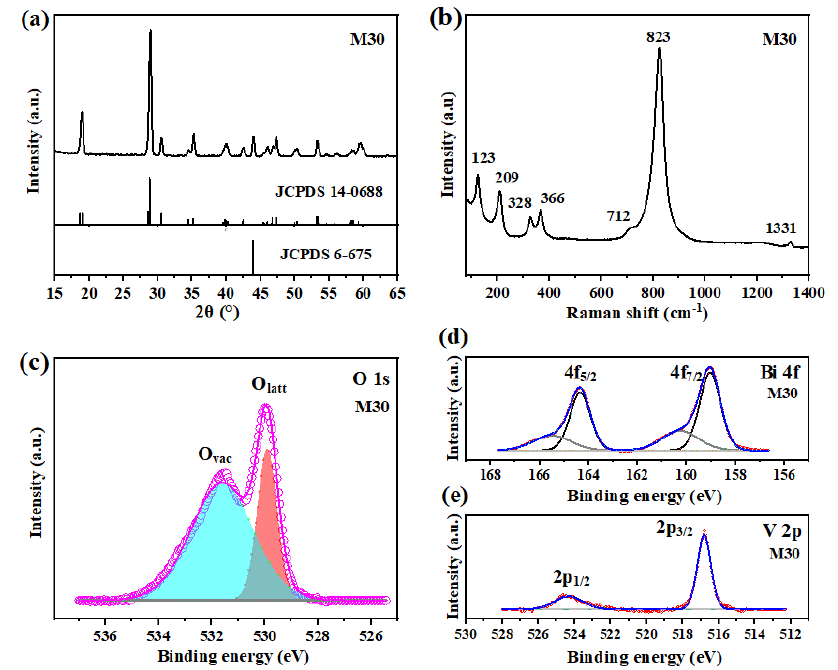
Figure 2. ( a ) XRD patterns, ( b ) Raman spectra, XPS spectra of ( c ) O 1s, ( d ) Bi 4f, and ( e ) V 2p for the M30 BiVO 4 /BDD heterojunction photoanode.